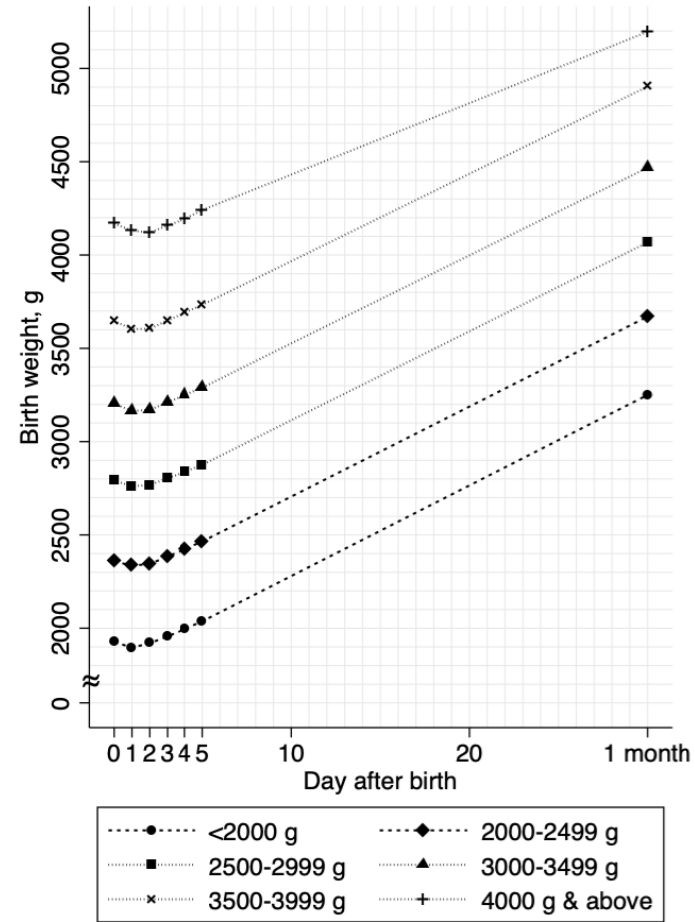
Figure 2. Body weight growth curves stratified by birth weights. The mean body weights are shown as connected lines stratified by birth weight categories. Values from day 0 through day 4 were estimated in 11,224 neonates; values at day 5 and 1 month (approximately 30 days of birth) were estimated in 10,336 neonates and 8071 neonates, respectively. Table 1. Background and clinical characteristics of 11,224 neonates who received optimal thermal control with sufficient nutrition.